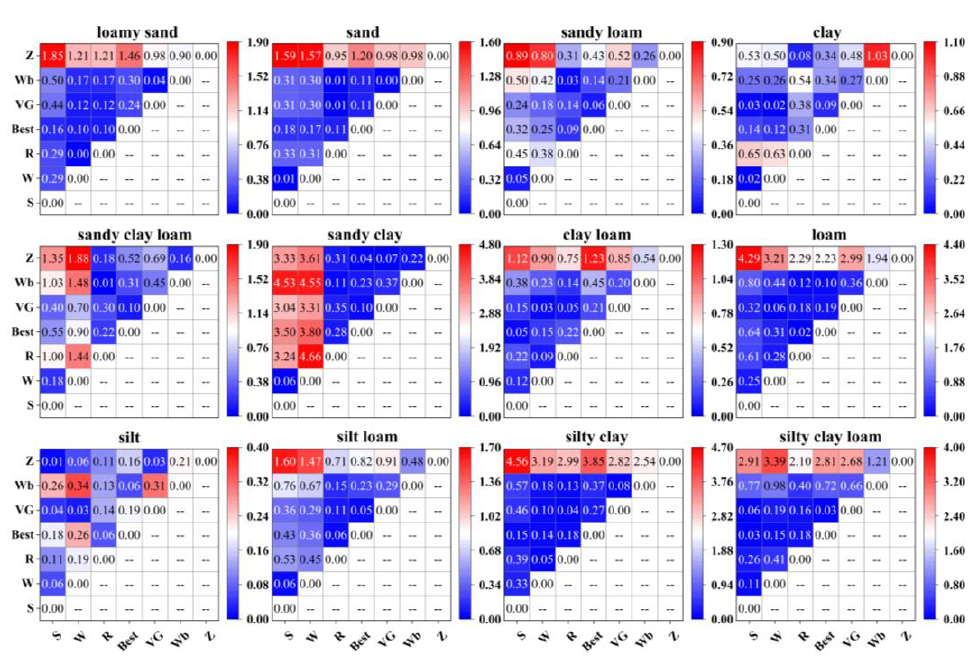
Figure 5. The absolute values of differences in seven soil particle size distribution models among twelve soil texture classes.